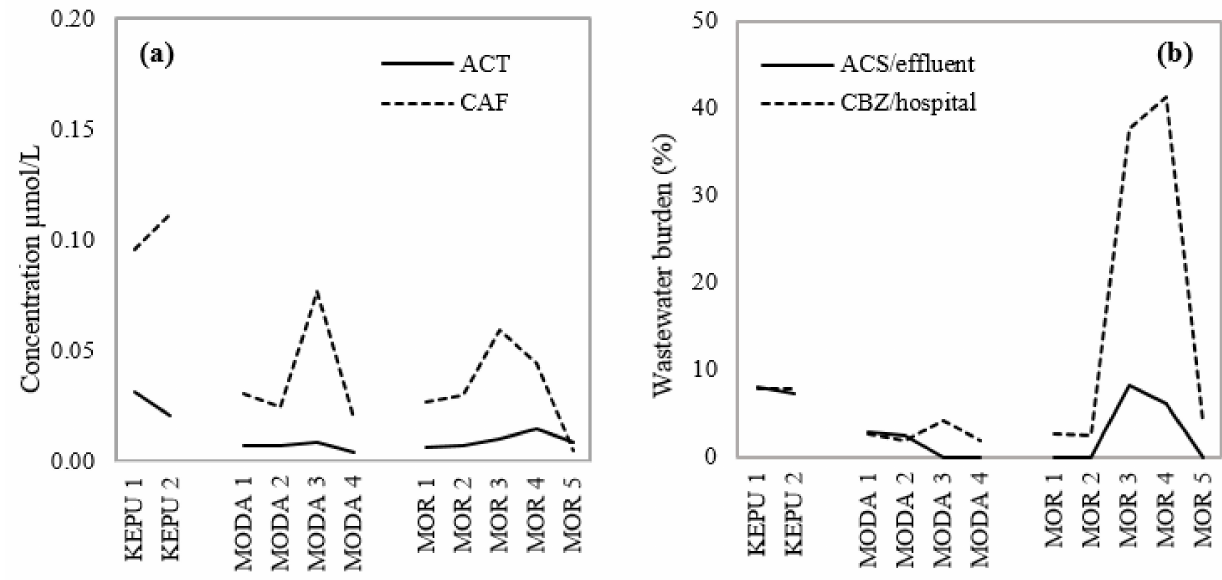
Figure 4. ( a ) Concentrations of labile compounds ACT and CAF in drainage samples and ( b ) wastewater burden (WB) factor of conservative compounds ACS and CBZ in drainage